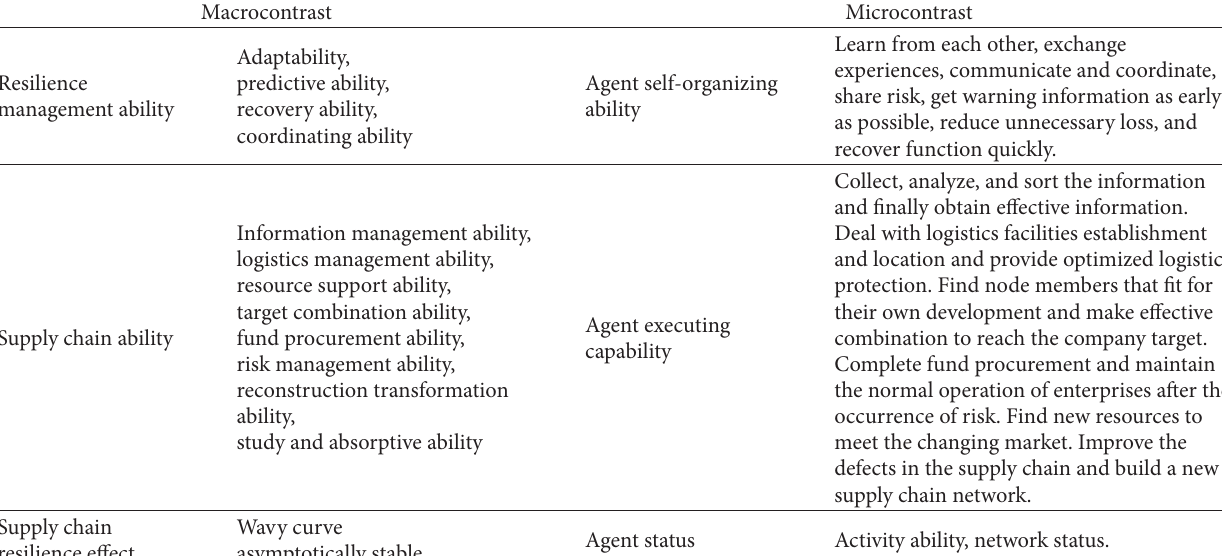
Table 3: Micro- and macrocontrast of supply